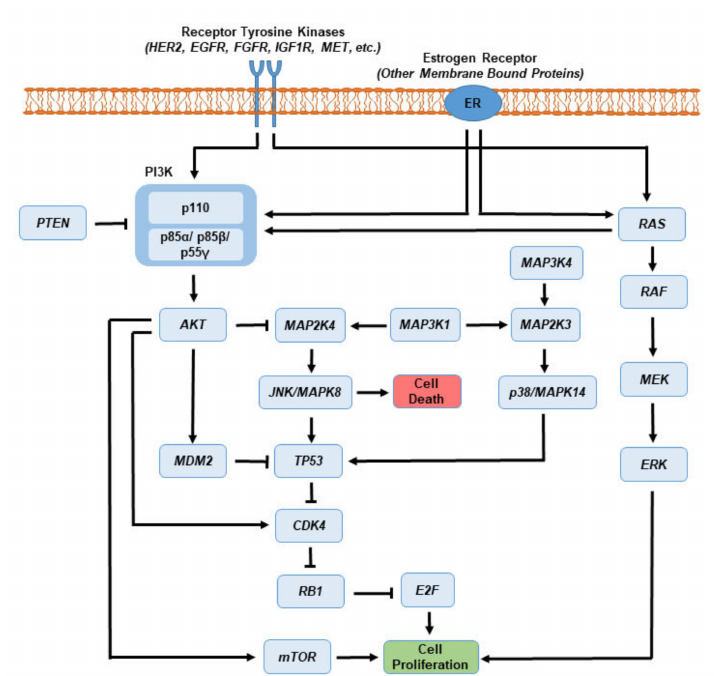
Figure 2. Involvement of frequently altered pathways in BCs include PI3K/AKT, KRAS/RAF/ERK, and TP53/RB1. Mutations of these signaling have been identified in genomic studies of different types of BC tumors, and are believed to play a critical role in tumor proliferation and resistance to apoptosis. PI3Ks, phosphatidylinositide 3-kinases; PIK3CA, PI3K catalytic subunit α ; PIK3R1, PI3K regulatory subunit α ; PTEN, phosphatase and tensin homolog; AKT, protein kinase B; mTOR, mechanistic target of rapamycin; KRAS, V-Ki-ras2 kirsten rat sarcoma viral oncogene homolog; RAF, v-Raf murine sarcoma viral oncogene homolog B; MEK/MAP2K/MAP2K3/MAP2K4, mitogen-activated protein kinase kinase; MAP3K1/MAP3K4, mitogen-activated protein kinase kinase kinase; MAPK8/JNK, mitogen-activated protein kinase 8; MAPK14/p38, mitogen-activated protein kinase 14; MDM2, mouse double minute 2 homolog; TP53, tumor suppressor p53; CDK4, cyclin-dependent kinase; RB1,